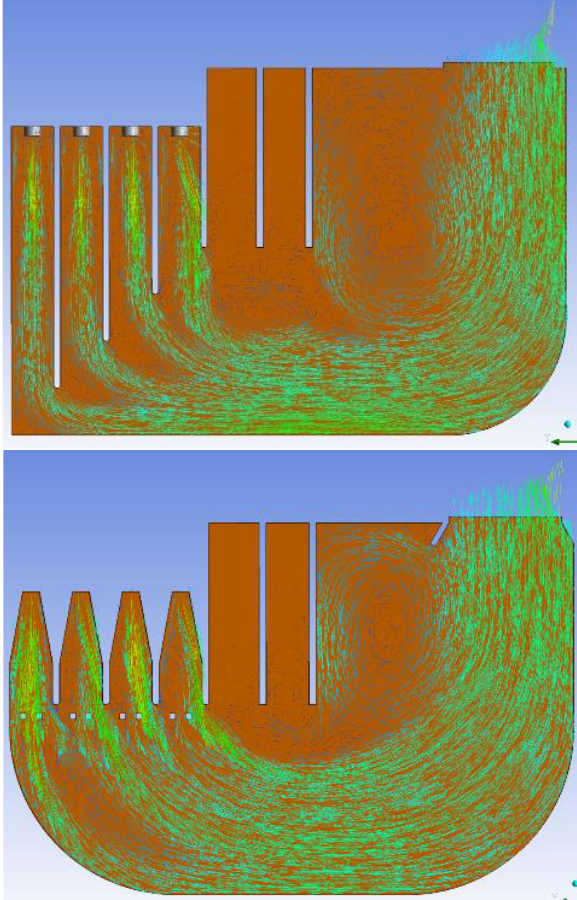
Figure 4. Starting pool geometry development.